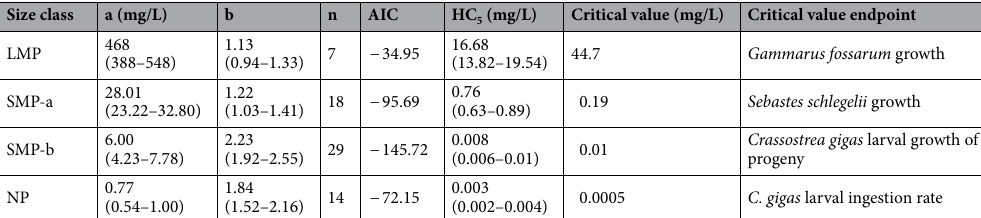
Table 3. Fitting parameters of SSD curves using log-logistic functions (see Material and methods) for diferent plastic particle size classes: large microplastics (LMP, > 100 μm), small microplastics between 10 and 100